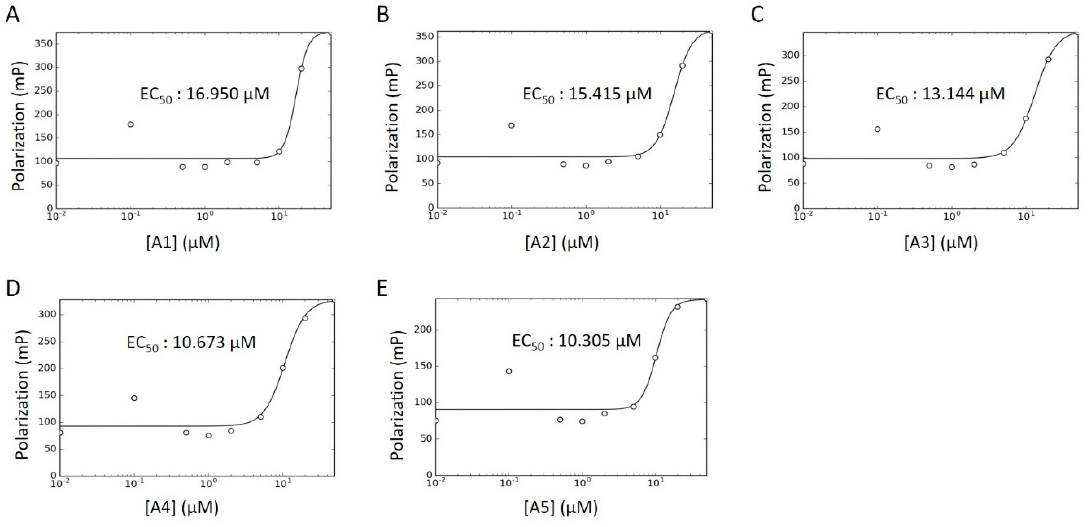
Figure 8. WT HYPE activator concentration–response curve. ( A – E ) FP plots from Δ 102 WT HYPE AMPylation reactions incubated with 0 to 200 μ M of DMSO-dissolved activators. All data were fitted to Equation (5) (see Methods) to determine EC 50 values. All reactions were done in detergent-less buffer.